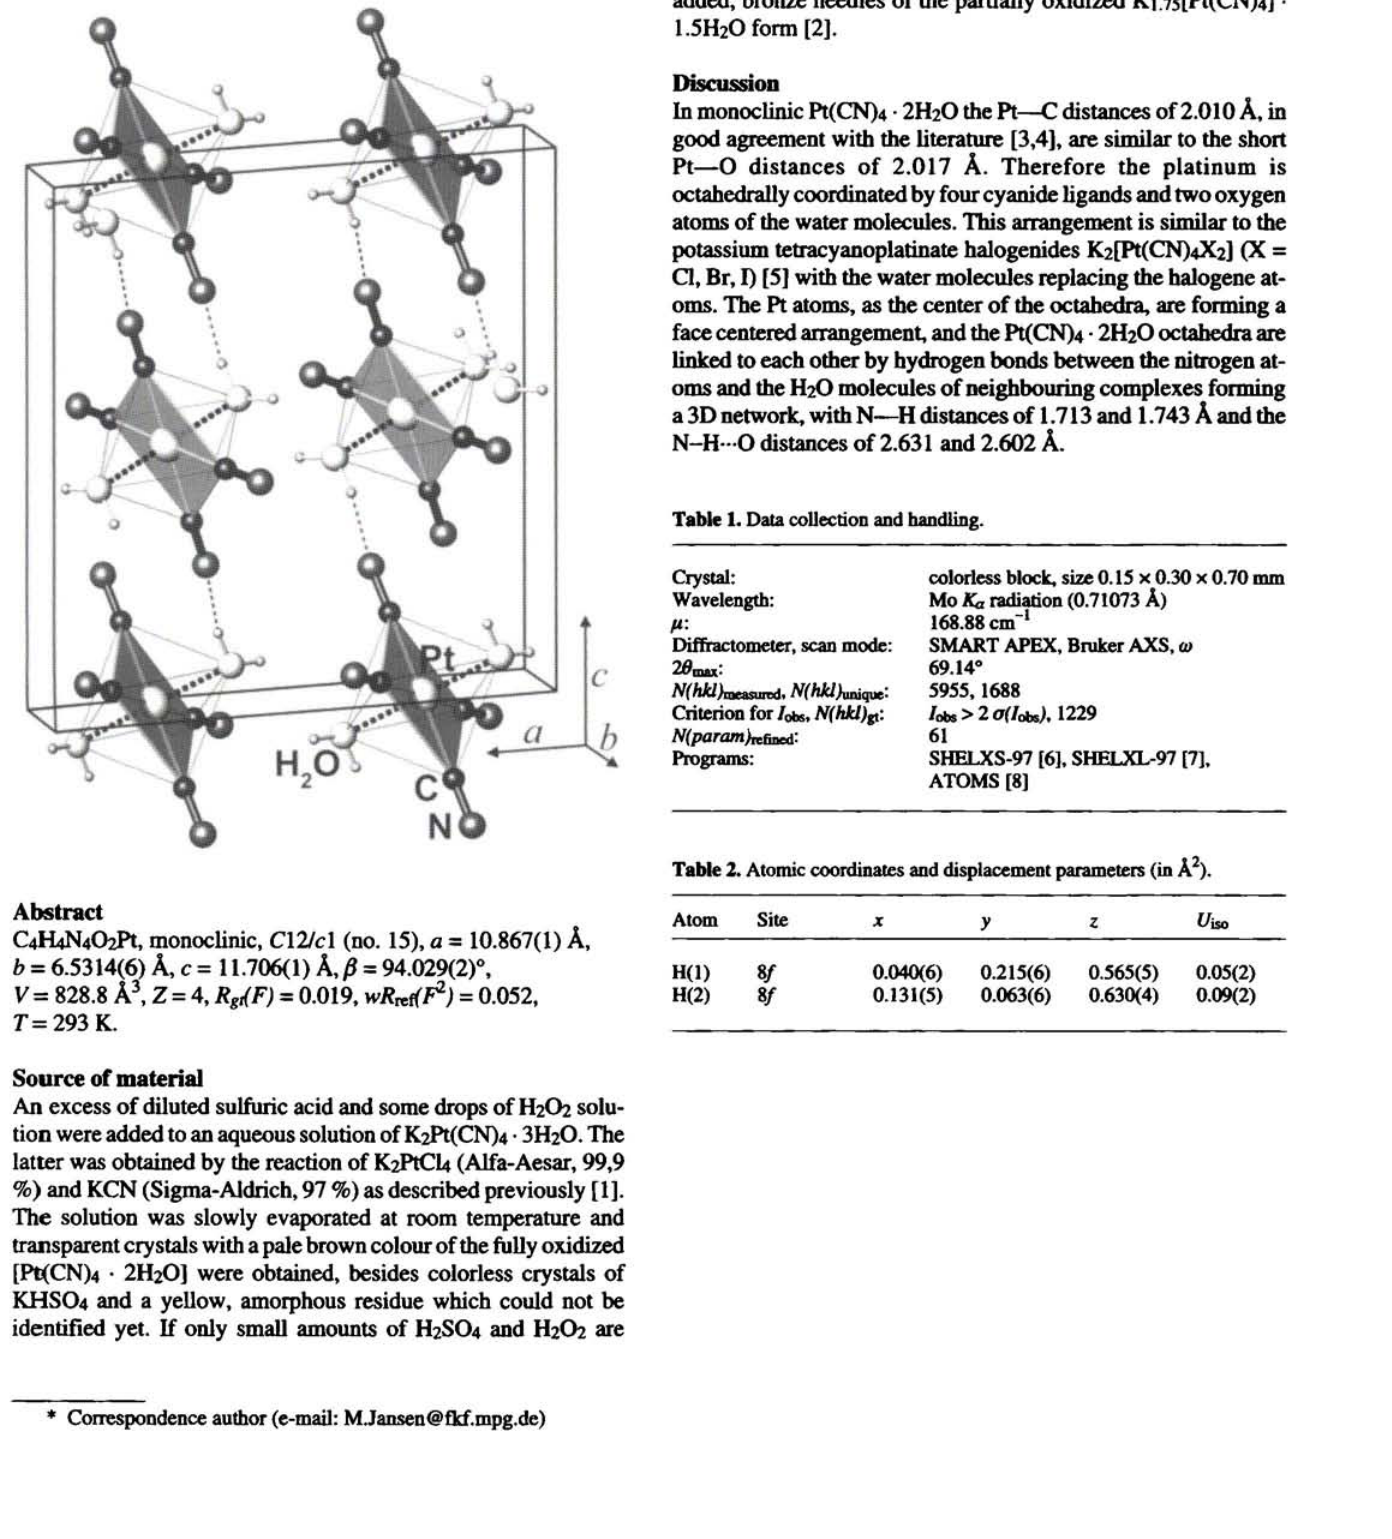
Table 1. Data collection and handling.